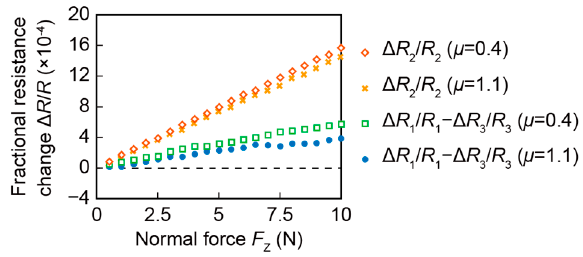
Figure 8. Response of the fabricated sensor to the normal force.